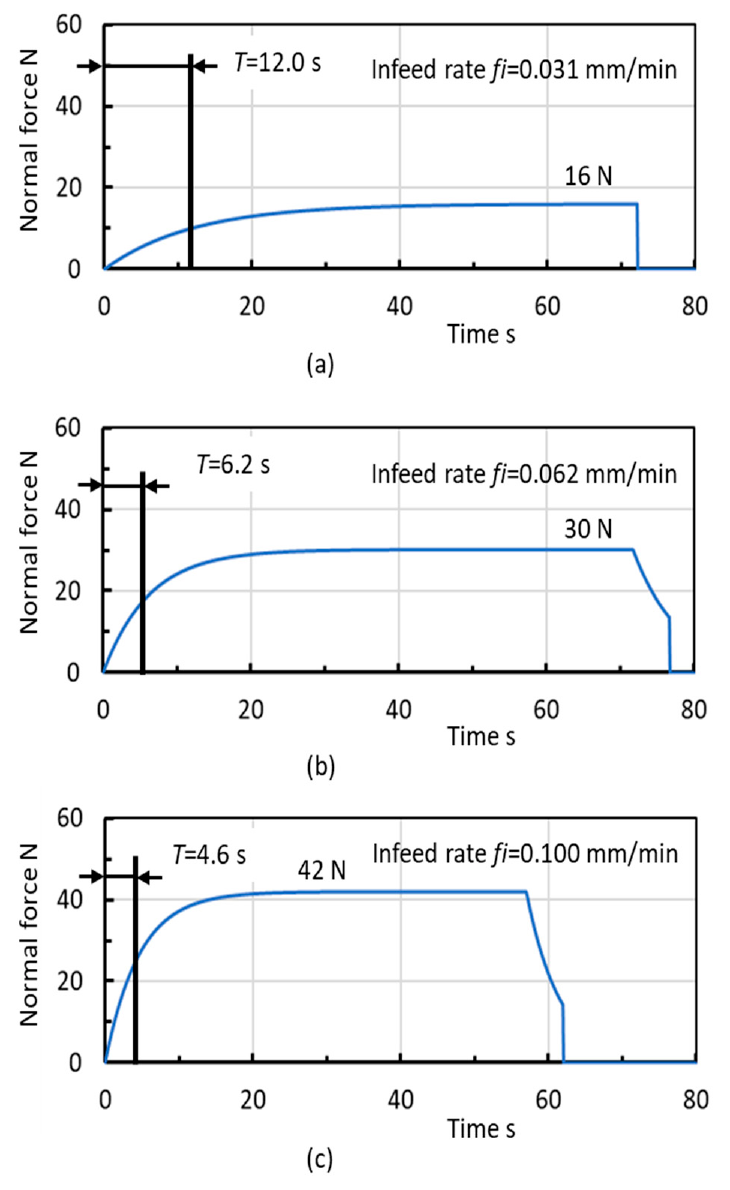
Figure 25. Simulations of plunge centerless grinding. ( a ) Q w (cid:48) = 0.01 mm 3 / mm · s; ( b ) Q w (cid:48) = 0.02 mm 3 / mm · s; ( c ) Q w (cid:48) = 0.0325 mm 3 / mm · s.